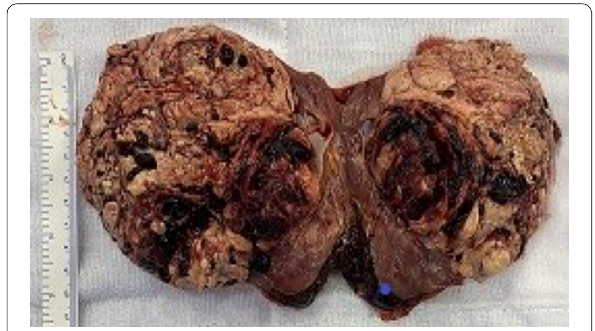
Fig. 2 Gross specimen after radical